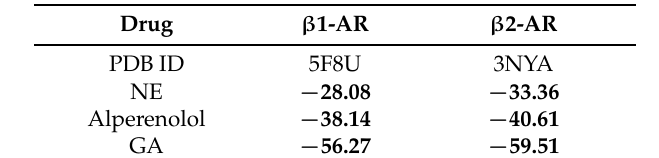
Table 1. Binding score after virtual docking of GA and alperenolol with 3D structures of beta adrenergic receptors ( β 1-AR and β 2-AR).